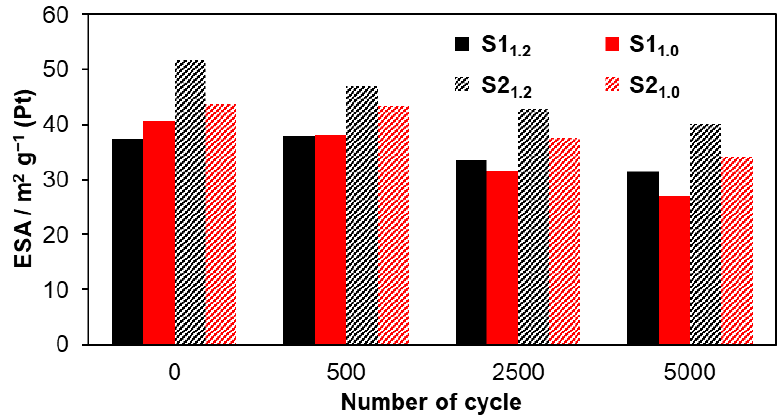
Figure 4. The ESA values of the PtCu/C catalysts during different stages of the ADT.